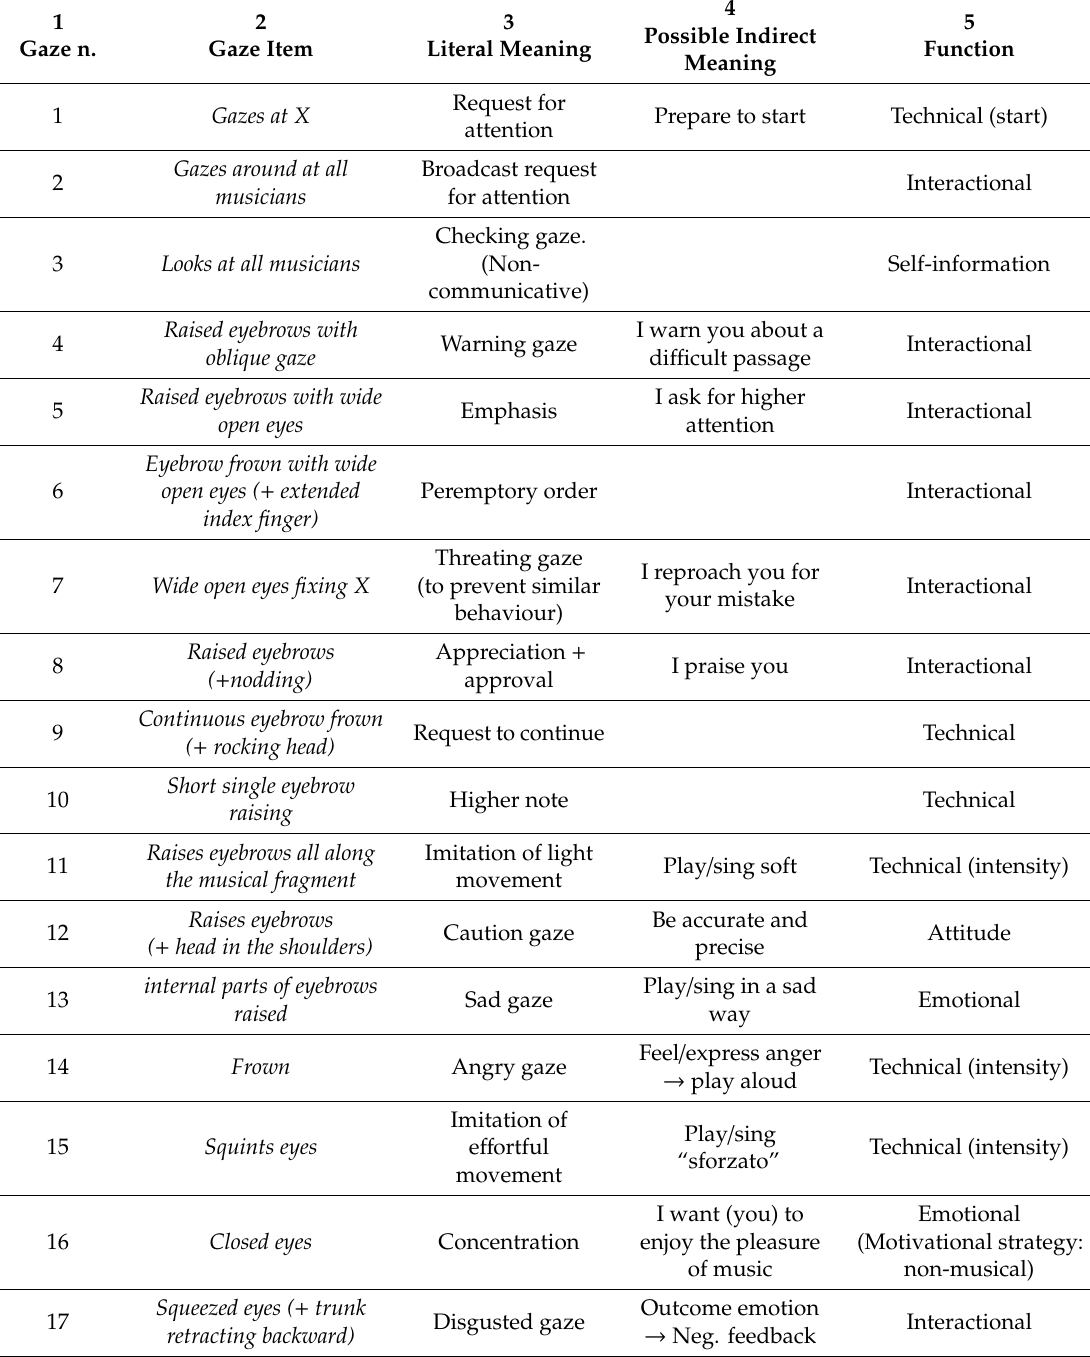
Table 1. The lexicon of the Conductor’s